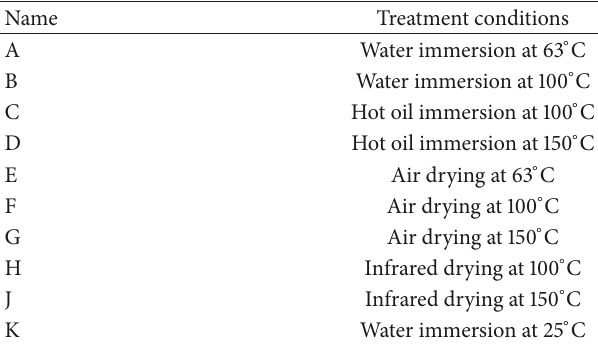
Table 1: Media treatments of bamboo